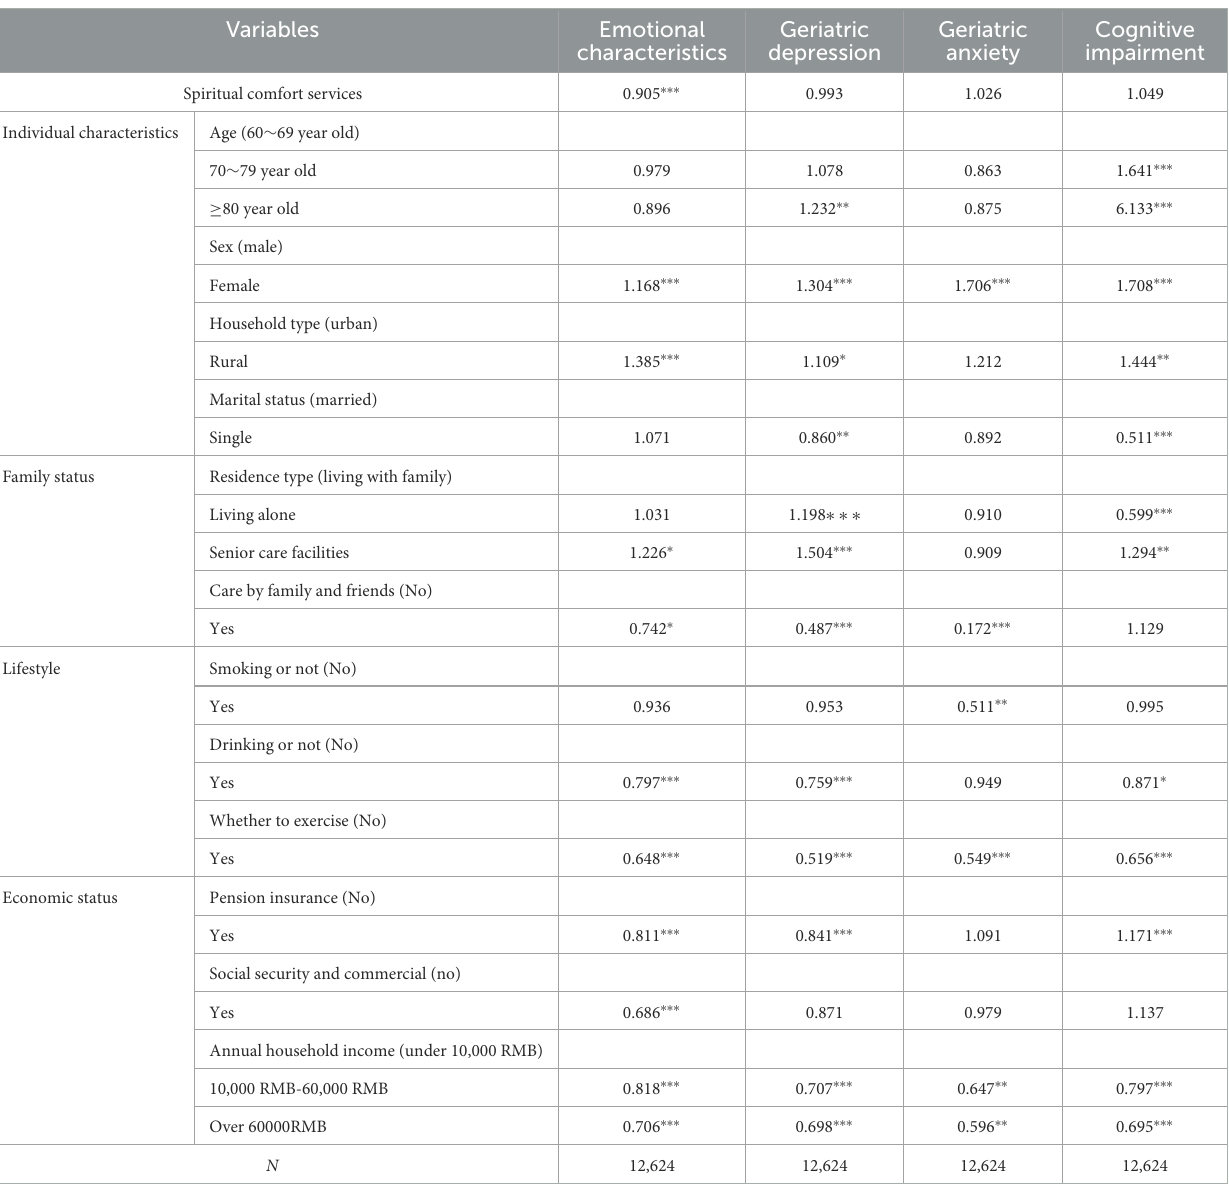
TABLE 5 Regression results of mental health level of older